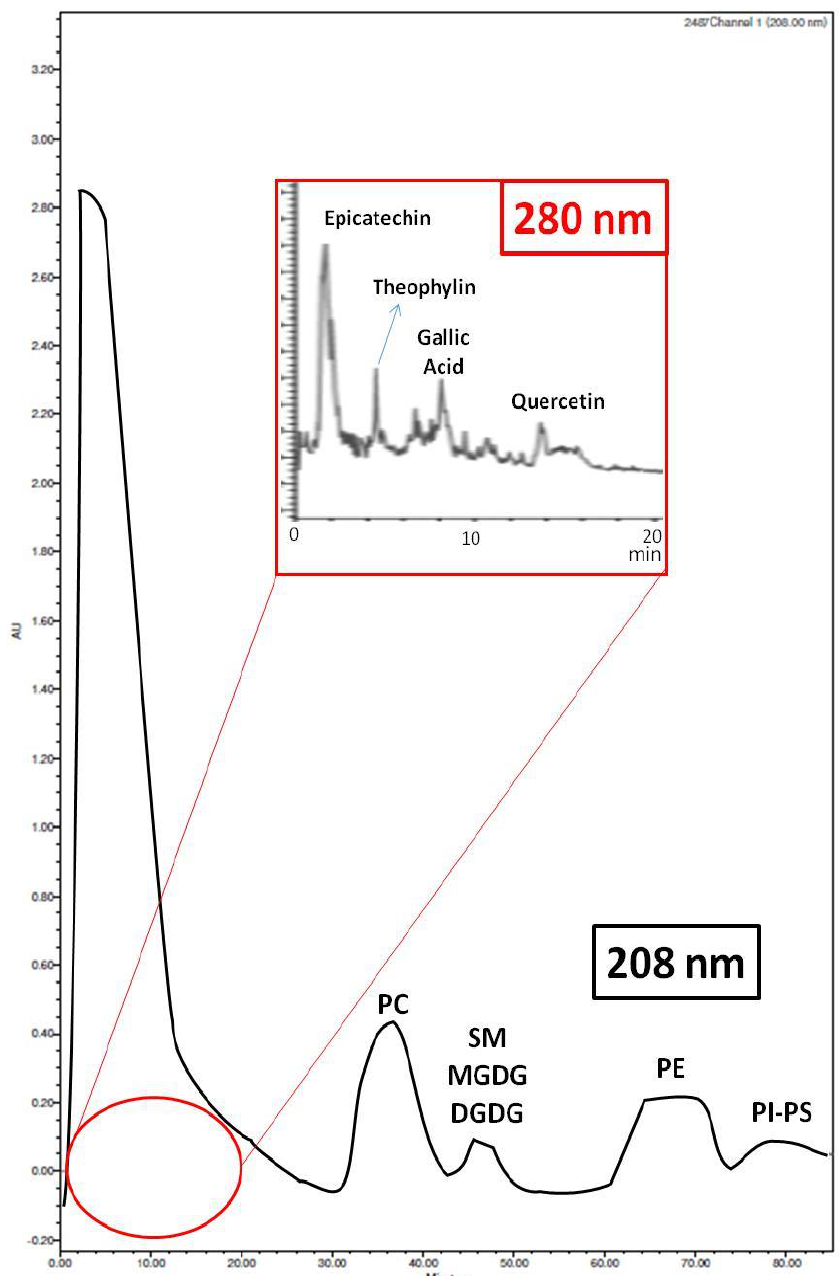
Figure 1. Representative chromatogram of HPLC analysis of ACBPs. Labeling of peaks was based on the use of specific standards and analysis in both 208 nm (for polar lipids) and 280 nm (for phe- nolic compounds). Abbreviations: PC, phosphatidylcholine; SM, sphingomyelin; PE, phosphati- dylethanolamine; PI, phosphatidylinositol; PS, phosphatidylserine; MGDG, monogalactosyldi- glyceride; DGDG, digalactosyldiglyceride; ACBP, apple cider by-product. Table 2. Fractionation of the PL 1 extracts for each ACBP 1 into HPLC fractions/PL subclasses with relative retention times, according to specific standards.